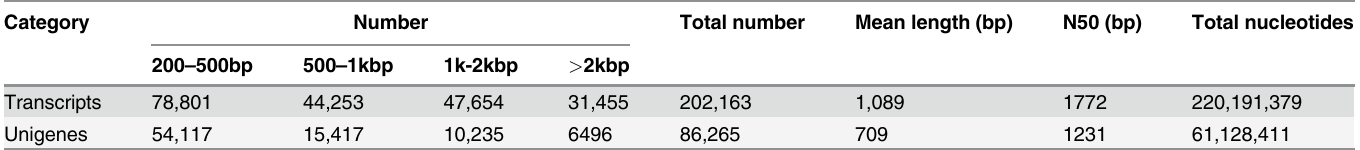
Table 1. Summary of the Caragana korshinskii transcriptome. Category